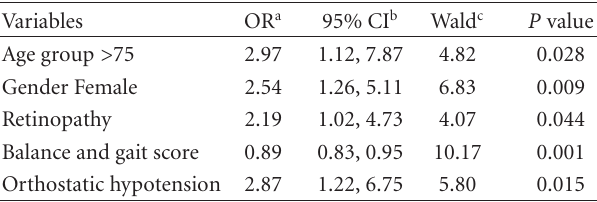
Table 3: Multiple logistic regression analysis of associated factor for fall among elderly diabetes.